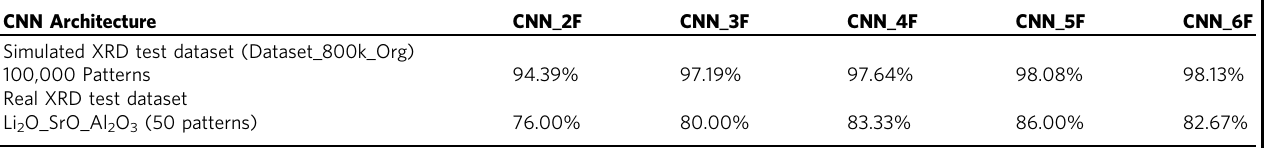
The three-level-phase-fraction prediction test results based on Dataset_800k_org. The CNNs were trained for 10